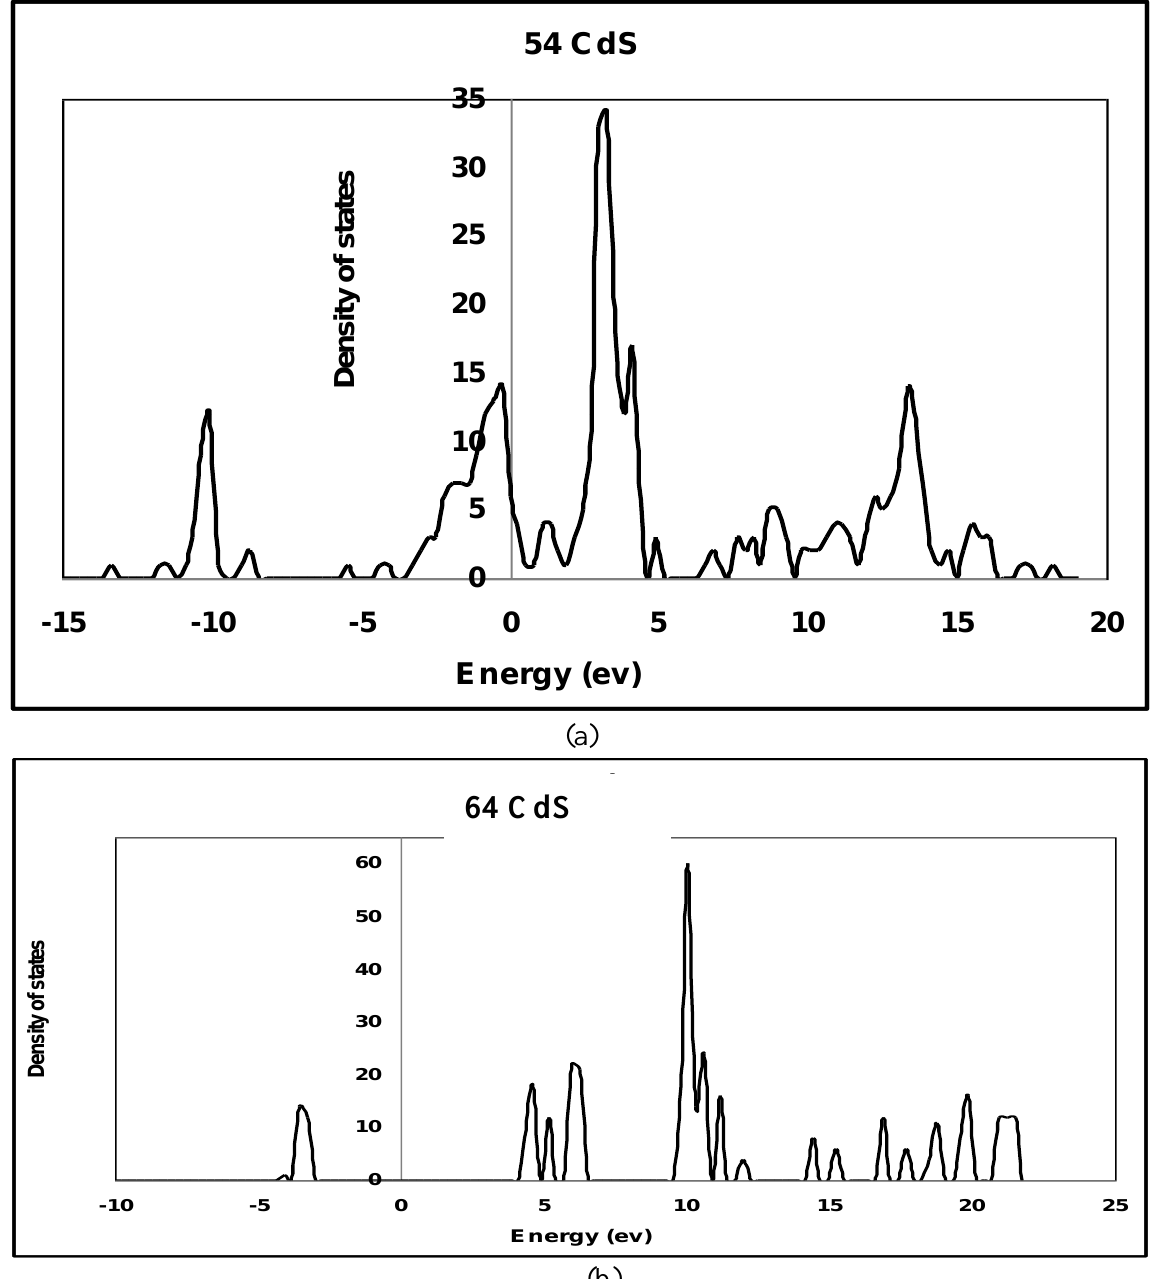
Fig. 9: Degeneracy of states of 54 and 64 atom LUCs (a and b respectively) as a function of energy levels are shown in this